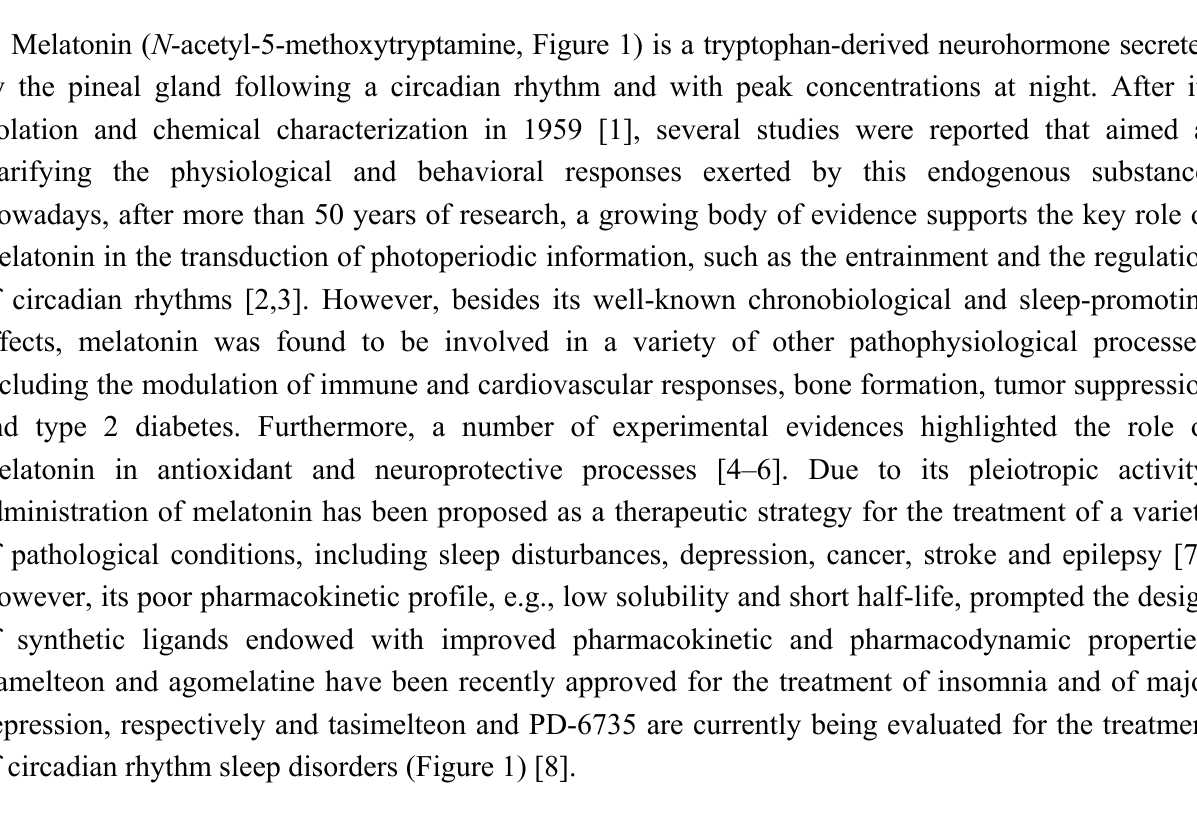
Figure 1. Melatonin and melatonergic agonists approved or currently tested in clinical